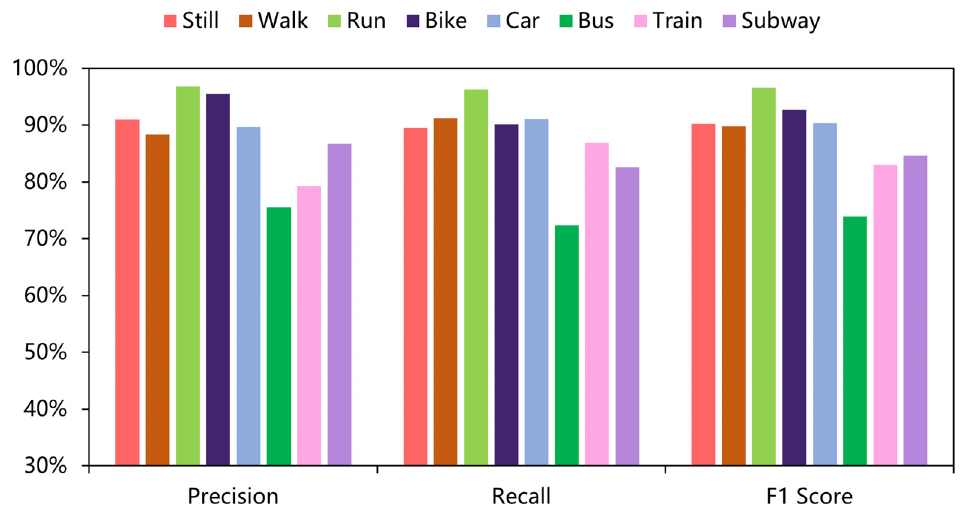
Figure 14. Performance evaluation results of the DFTrans model on the HTC dataset for eight classifications.